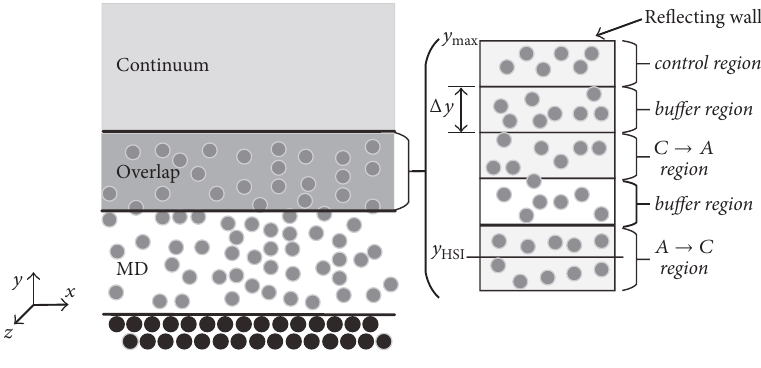
Figure 3: Detailed schematic diagram of the overlap